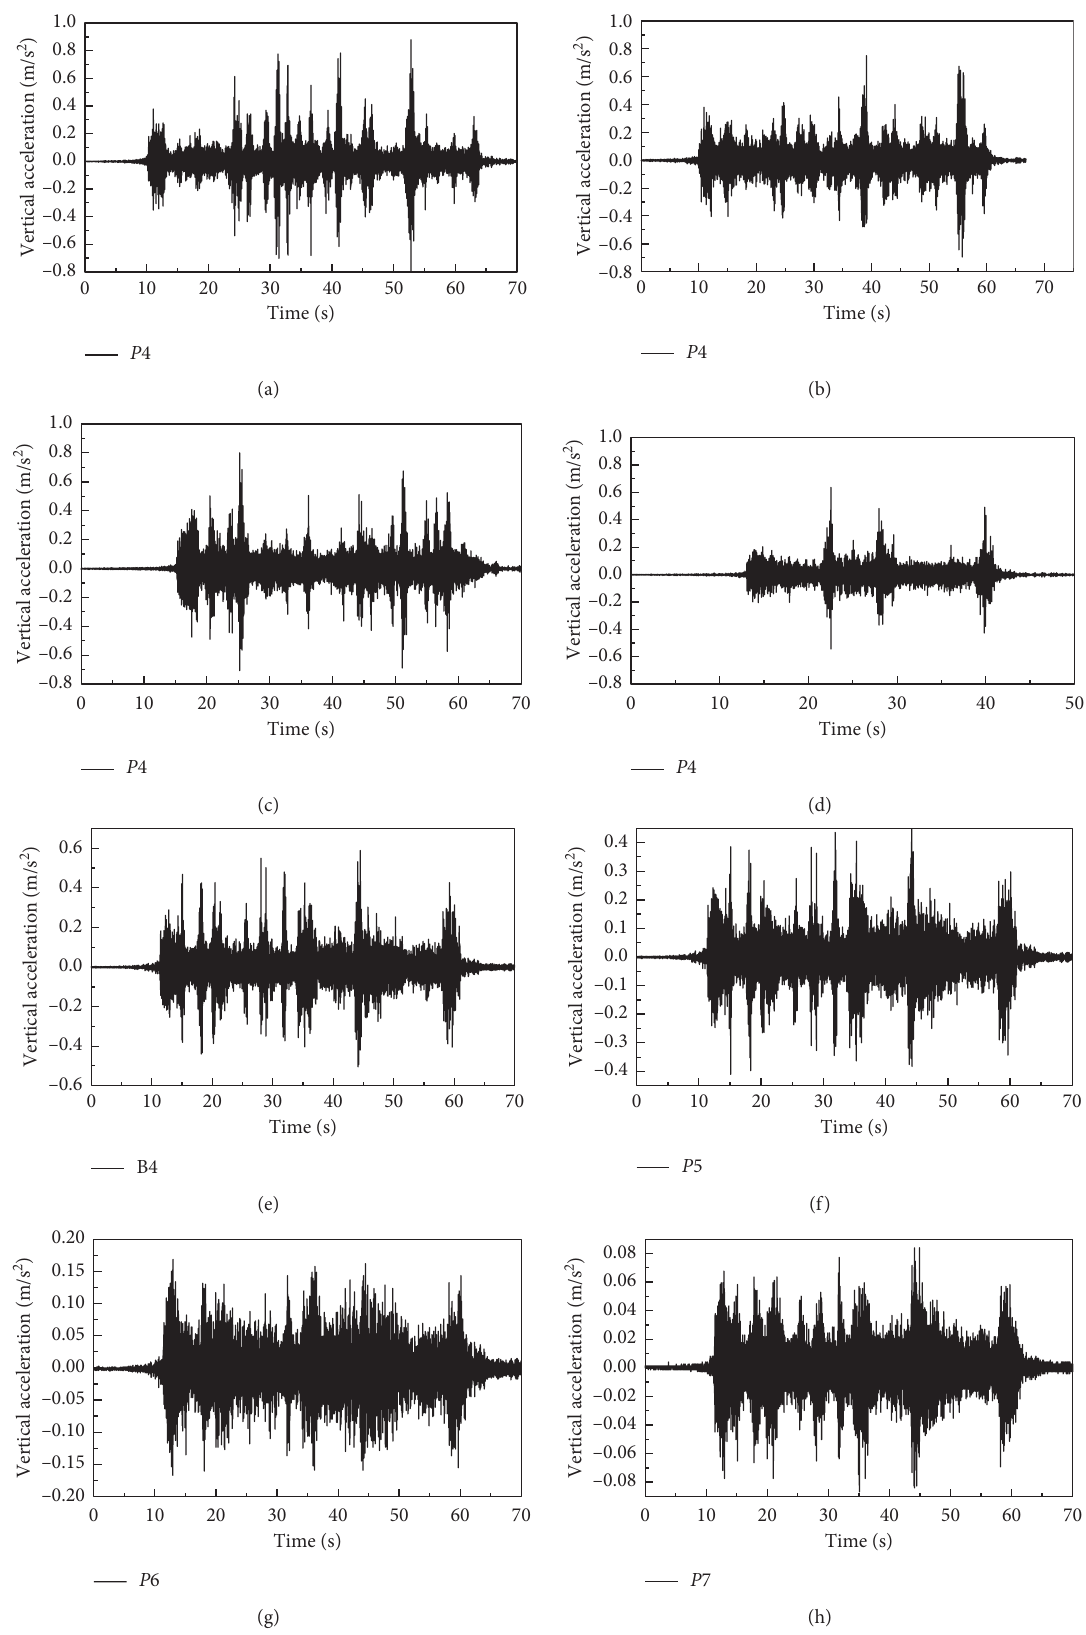
Figure 3: Acceleration-time-history curves. (a) Freight train 11404. (b) Freight train 11114. (c) Freight train 11138. (d) Freight train 40194. (e) Freight train 11022. (f) Freight train 11022. (g) Freight train 11022. (h) Freight train